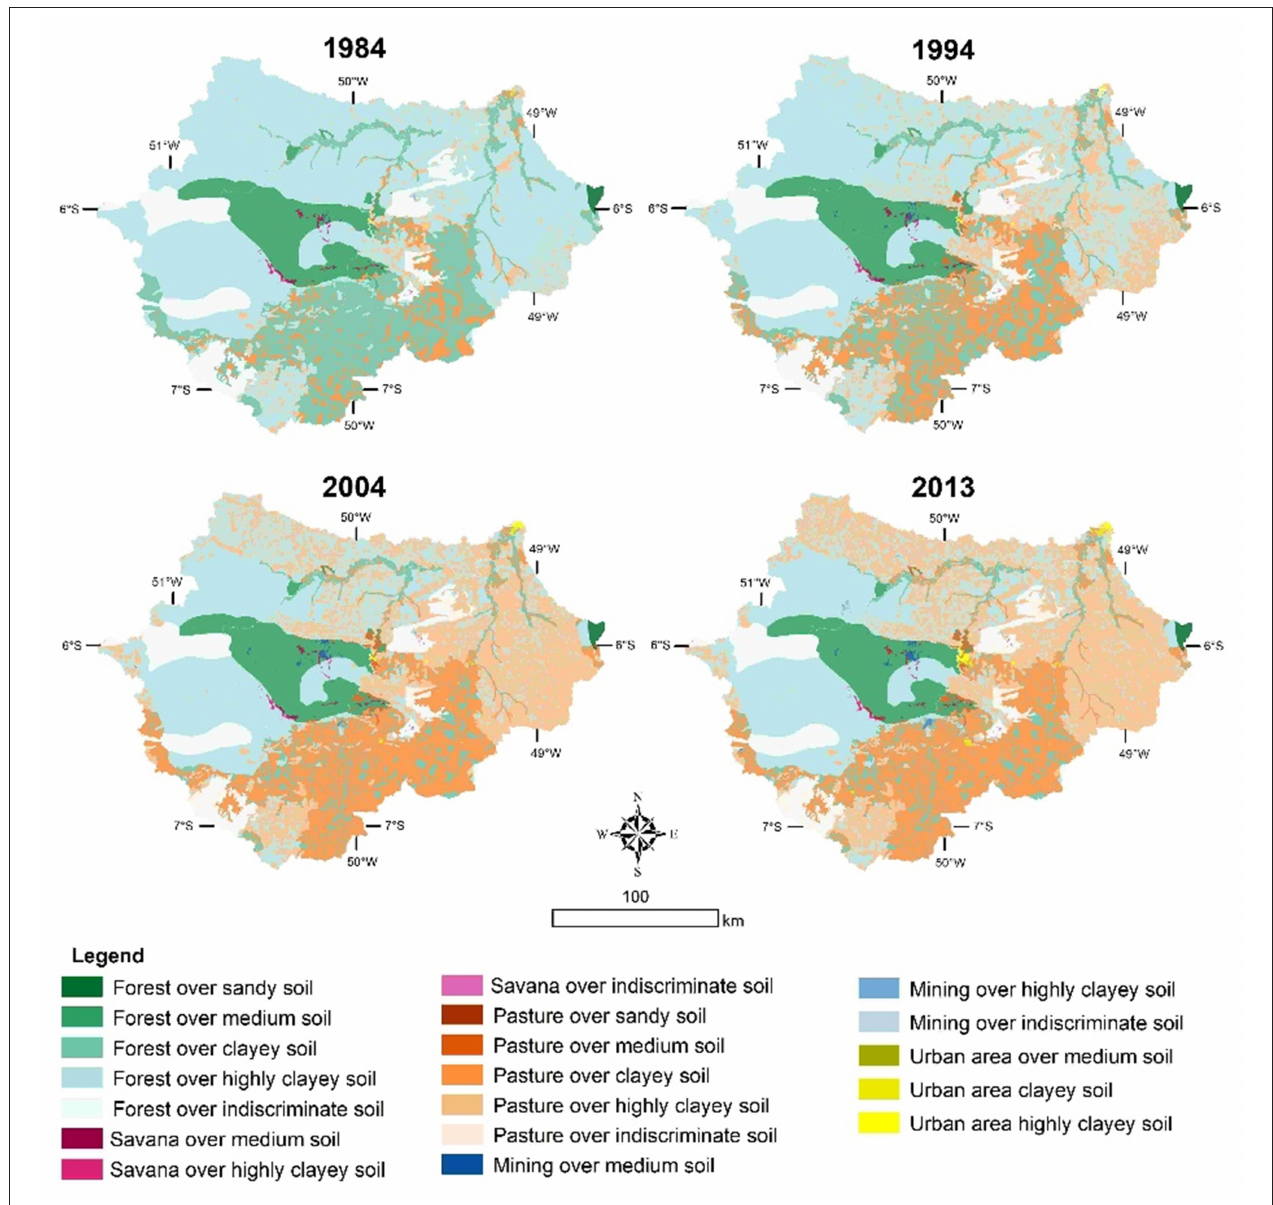
FIGURE 2 | Evolution of the conversion from forest to pasture over the decades along with the soil textures identified in the IRW (1984–2013). Source: Silva Júnior et al.